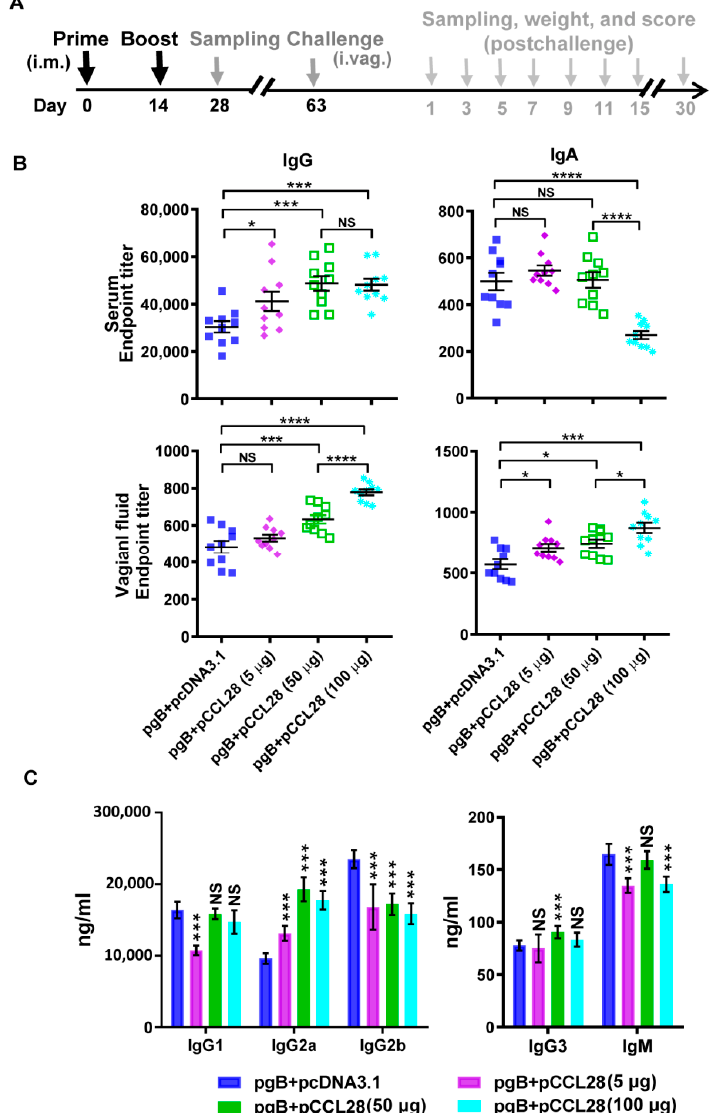
Figure 1. Immunization and challenge procedures, as well as humoral immune responses. ( A ) Schedule of i.m. immunization and i.vag. challenge. Mice ( n = 10/group) were immunized twice with pcDNA3.1, pgB + pcDNA3.1, and pgB + pCCL28 (5, 50, and 100 μ g, respectively) in saline solution on days 0 and 14. On day 14 post boost (day 28), some mice ( n = 5/group) were sacrificed for sampling. Then, 49 days post boost (day 63), the remaining mice ( n = 5/group) were used for challenge experiments. The weight and clinical symptoms of post-challenge mice were monitored daily for 15 days. Serum, vaginal fluid, and sacral ganglia samples were collected at the indicated time for subsequent tests. ( B ) Induction of systemic and mucosal Ab responses against gB. After mice underwent day 0 and 14 electroporation, as well as “prime and boost” i.m. immunization, the endpoint titers of gB-specific IgG and IgA of sera and vaginal fluids ( n = 10/group) were deter- mined by direct ELISA. ( C ) The concentrations of gB-specific IgG1, IgG2a, IgG2b, IgG3, and IgM isotypes in sera were quantified by ELISA post boost. On day 14 post boost, the titer of each gB-specific Ig subclass was calculated according to the standard curve obtained using the corre- sponding standard Ig subclass. Data are expressed as the means ± SEMs pooled from three inde- pendent experiments, with each condition performed in duplicate. The indicated p -values show statistically significant differences between the antigen group (pgB + pcDNA3.1) and the pgB + pCCL28 (5, 50 or 100 μ g) group, as determined by a nonparametric Student’s t -test. NS, not statis- tically significant; * p < 0.05; *** p < 0.001; **** p < 0.0001.